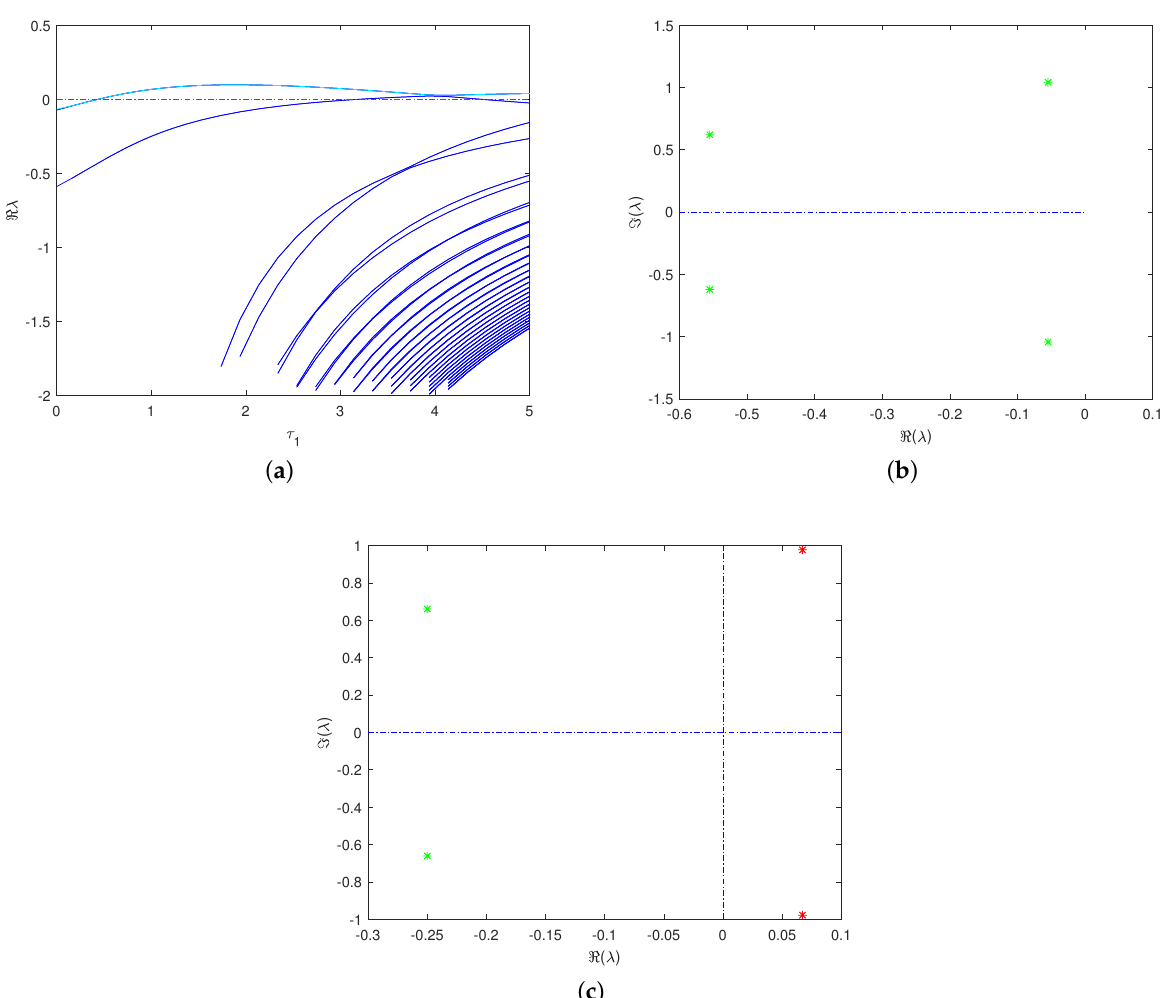
Figure 2. When τ 2 = 1, ( a ) the eigenvalue diagrams of the system for τ 1 kept changing, ( b ) shows the real and imaginary parts of eigenvalue diagrams of the system for τ 1 = 0.1, and ( c ) shows the real and imaginary parts of eigenvalue diagrams of the system for τ 1 = 1.